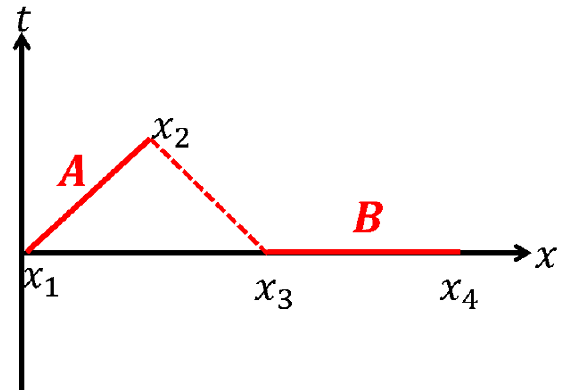
Figure 4 . Setup of mutual information I ( A; B ) between two intervals A and B when A is in(cid:12)nitely